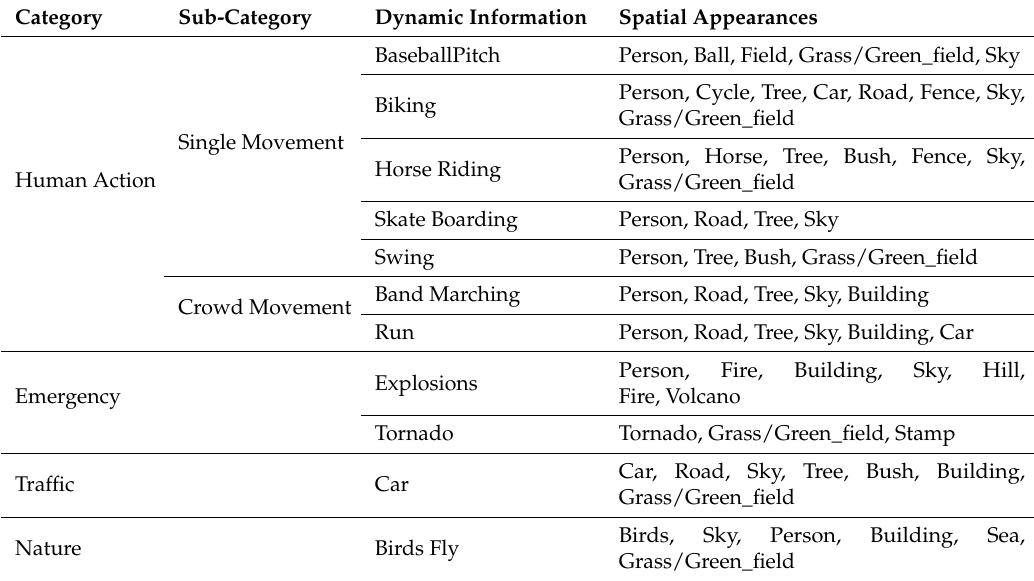
Figure 10. Sample frames of the proposed STAD video dataset. Table 1. Description of proposed STAD video